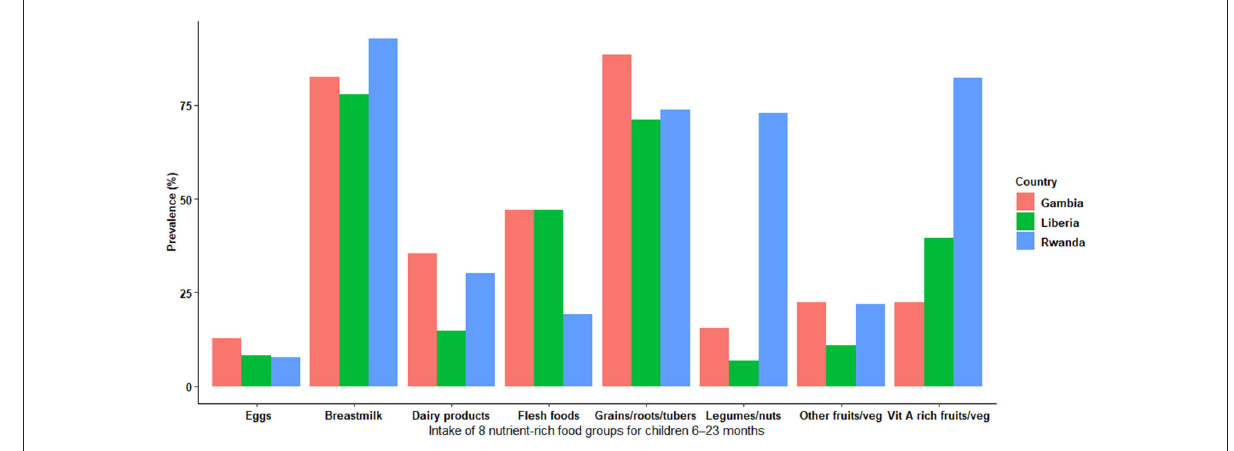
FIGURE1 Weighted prevalence of intake of 8 nutrient-rich food groups for children 6–23